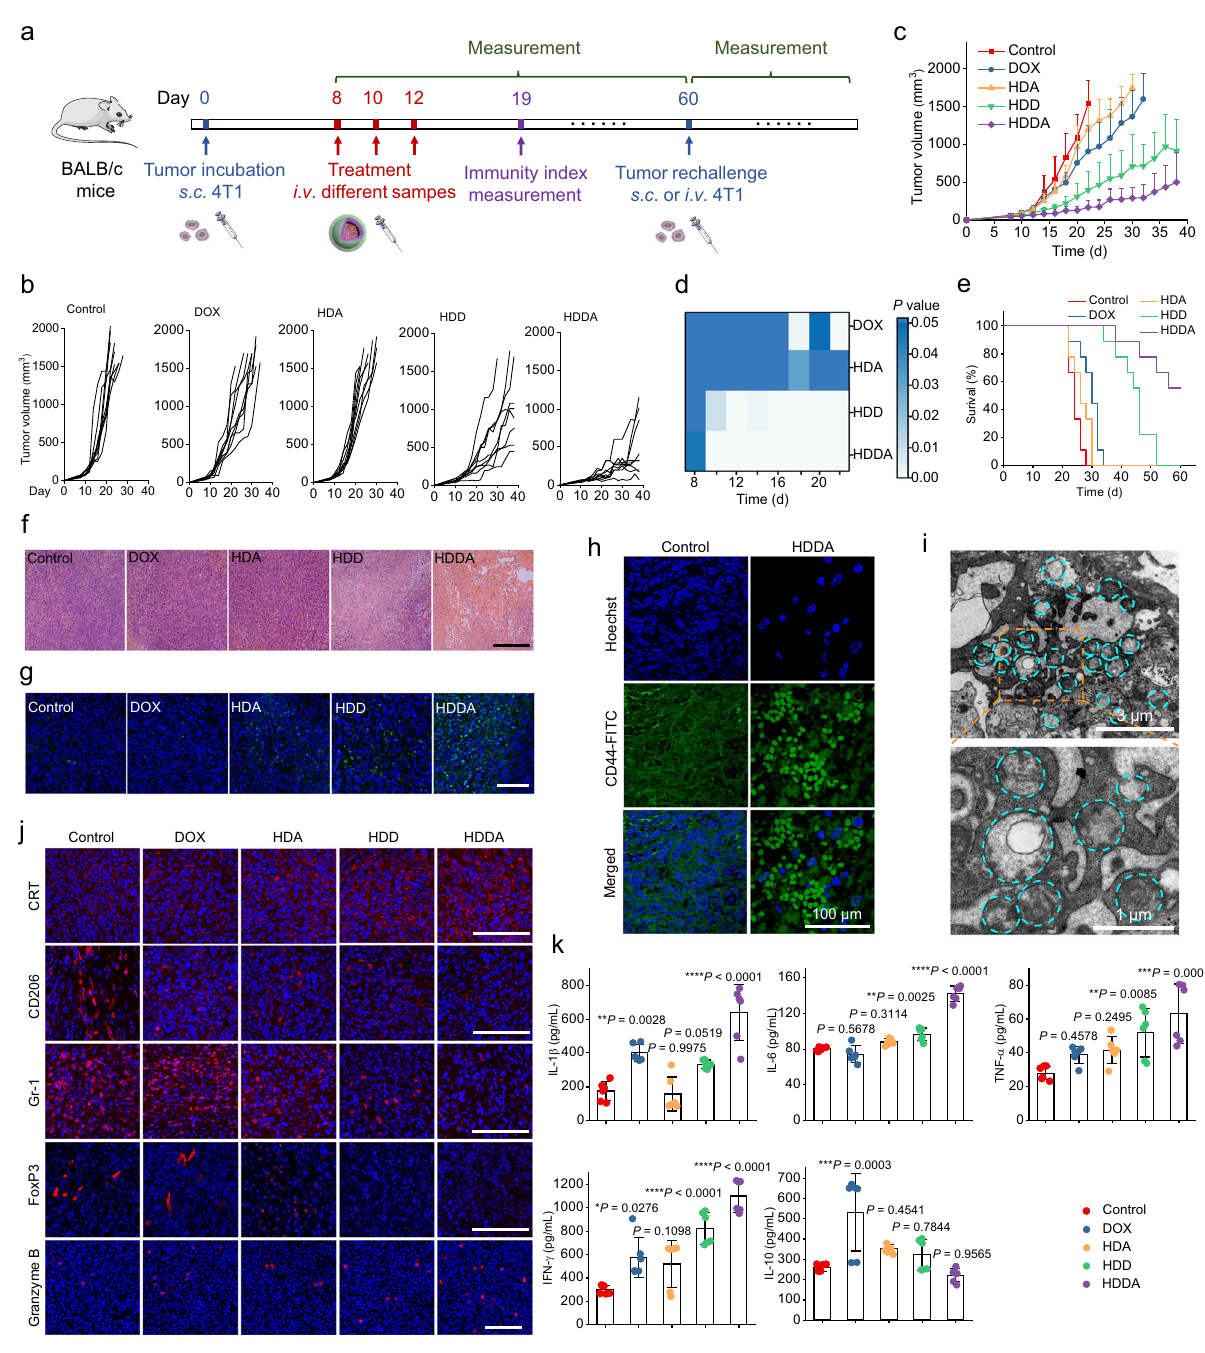
Fig. 5 | HDDA NBs display high antitumor therapeutic ef fi cacy and strong intratumoral immunostimulatory effect in the 4T1 tumor model. a Experimental outline showing the treatment steps and the procedures for eval- uatingthetherapeuticandimmunostimulationoutcomesofdifferentgroupsin4T1 tumor-bearingBALB/cmice. b Individual4T1tumorgrowthcurvesofthemiceafter different treatments. c Average tumor growth curves of the 4T1 tumor-bearing BALB/cmiceaftervarioustreatmentsand d correspondingheatmapofthe P values betweenthecontrolgroupandothergroups.ThemicetreatedwithPBSweresetas the control group. Data are presented as mean+SD. n =9 mice per group. e Survival rates of the 4T1 tumor-bearing BALB/c mice after various treatments. f , g Confocal microscopic images ofrepresentative H&E staining results (scale bar: 300 μ m) ( f ) and TUNEL assay results (scale bar: 100 μ m) ( g ) of the tumor tissue slices from the 4T1 tumor-bearing BALB/c mice sacri fi ced at day 7 after different treatments. Before imaging, the cell nuclei were stained with Hoechst 33342 (Hoechst). h Representative confocal fl uorescence images of the CD44 (green)